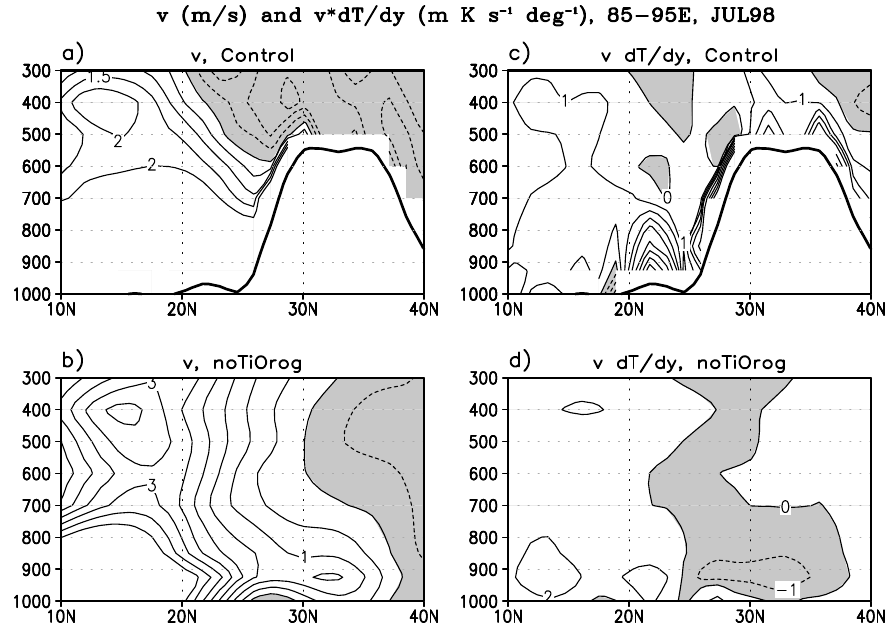
Fig. 13. Vertical profile of meridional velocity from the (a) control and (b) noEhOrog simulations averaged between 85 ◦ –95 ◦ E. Vertical profiles of temperature (energy) advection from the (c) control and (d) noEhOrog simulations are shown for the same region.